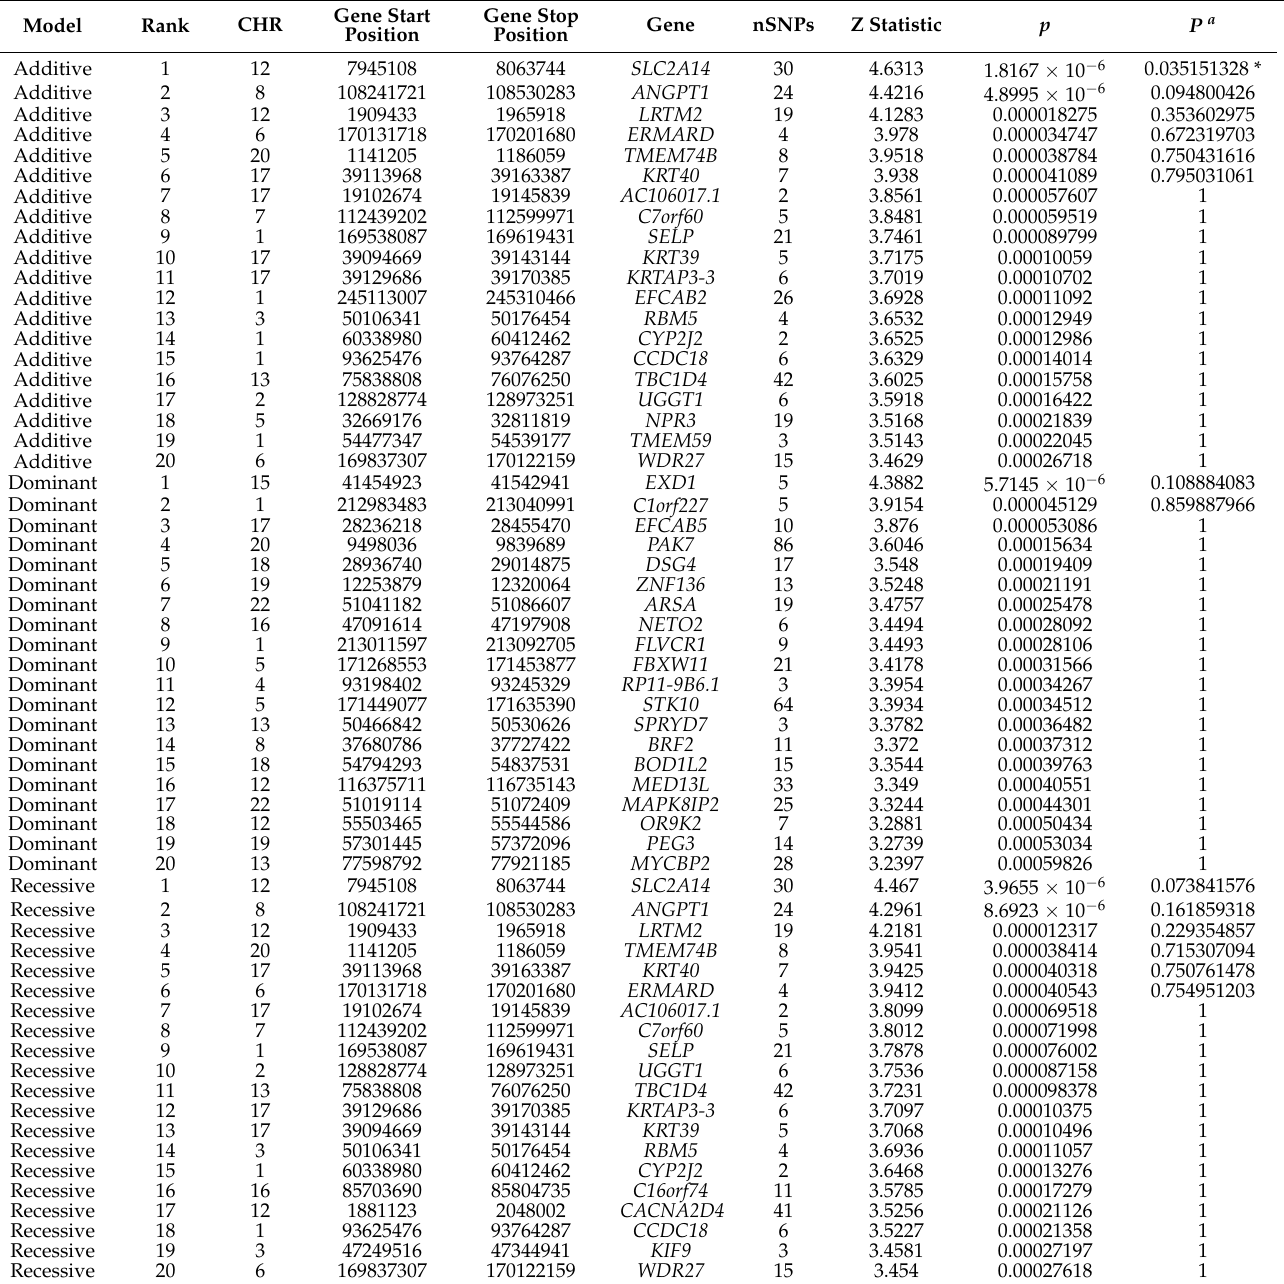
Table 5. Top 20 candidate genes selected from gene-based